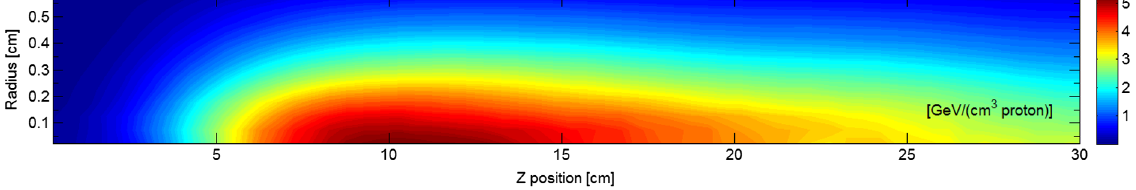
FIG. 7. Energy deposition in the tungsten-helium compound for 440 GeV, 2 mm beam sigma.